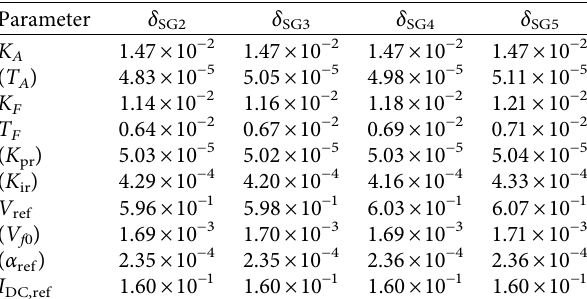
Table 3: Te TS indices for δ 2 to δ 5